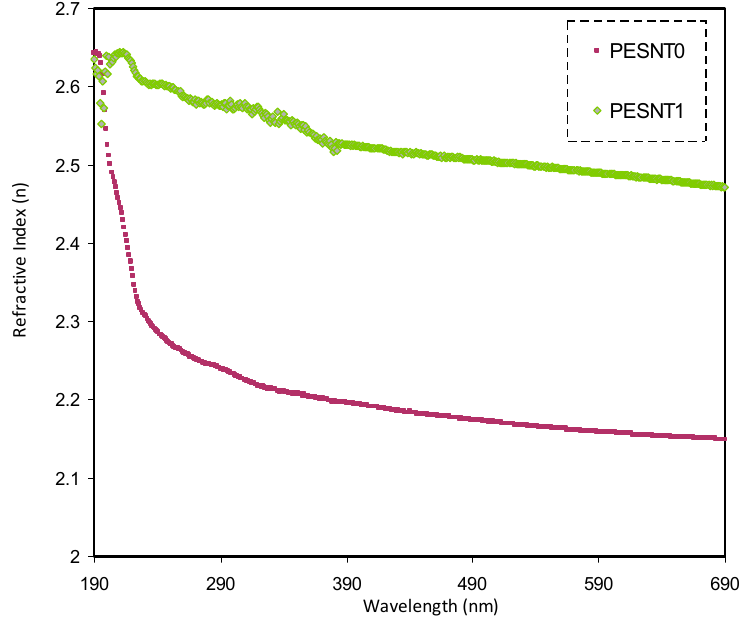
Figure 4. Refractive index ( n ) of pure PEO (PESNT0) and PEO:SnTiO 3 (PESNT1) samples.